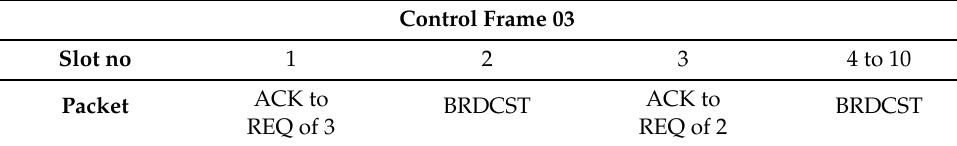
Table 8. Third control frame contains transmissions of all